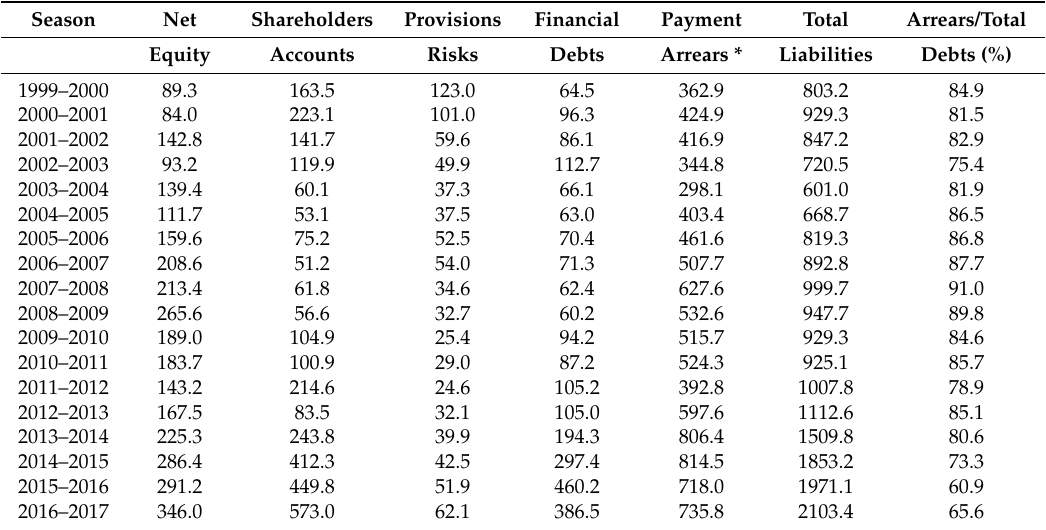
Table 6. The Ligue 1 balance sheet: liabilities, 2000–2017 (million €